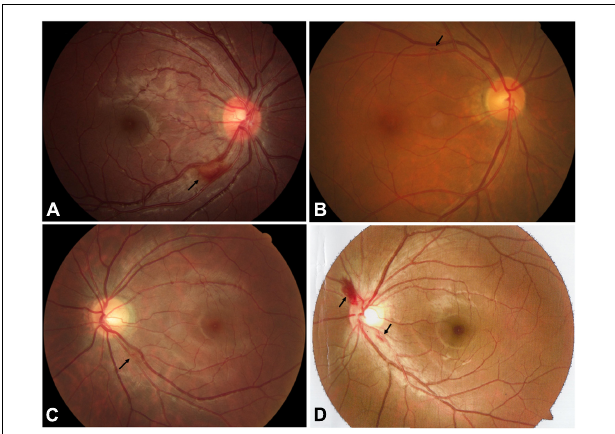
FIGURE 2 | Fundus appearance of 4 patients with retinal hemorrhage (black arrows). (A) Retinal hemorrhage located at the inferior temporal side of the optic disc in the right eye of the patient A781. (B) Retinal hemorrhage located at the superior temporal side of the optic disc in the right eye of the patient A2579. (C) Retinal hemorrhage located at the inferior temporal side of the optic disc in the left eye of the patient A3198. (D) Retinal hemorrhages located at the border of the optic disc in the left eye of the patient E004.